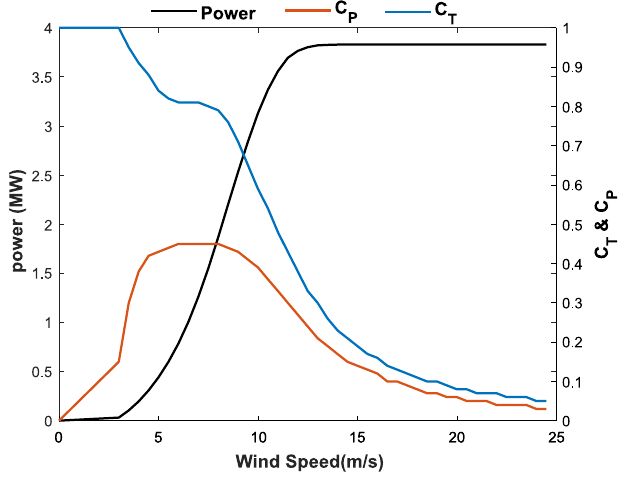
Figure 1. Power curve of a 3.83-MW wind